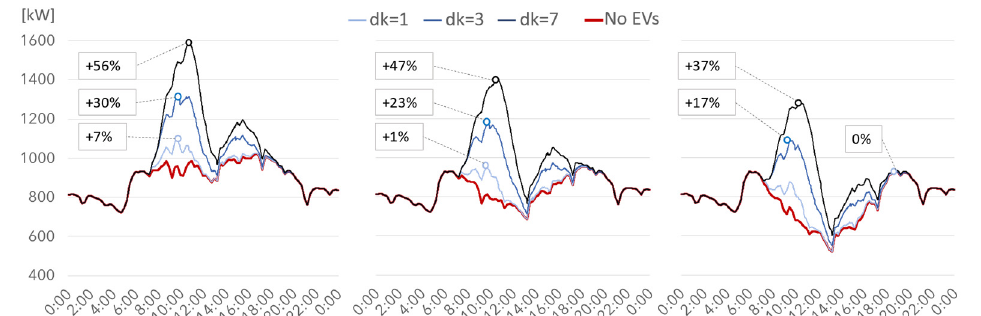
Figure 10. Comparison of the self ‐ consumptions: the red curves are the PV power, the blue curves are the 𝑃 (cid:3006)(cid:3023)(cid:3046) with 𝑑 (cid:3038) = [1;3;7], and the percentage value in the legend shows the 𝜂 (cid:3020)(cid:3004) in: worst condition ( blue areas , left plot ); mean condition ( green areas , center plot ); best condition ( orange areas , right plot ).